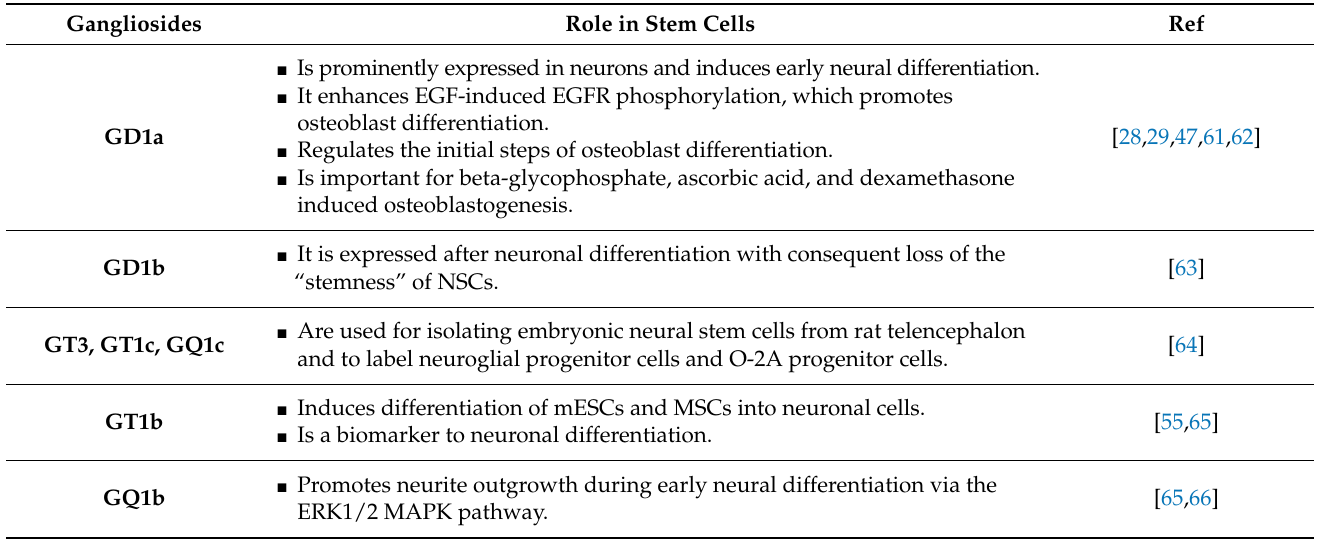
Table 1. Cont. Gangliosides Role in Stem